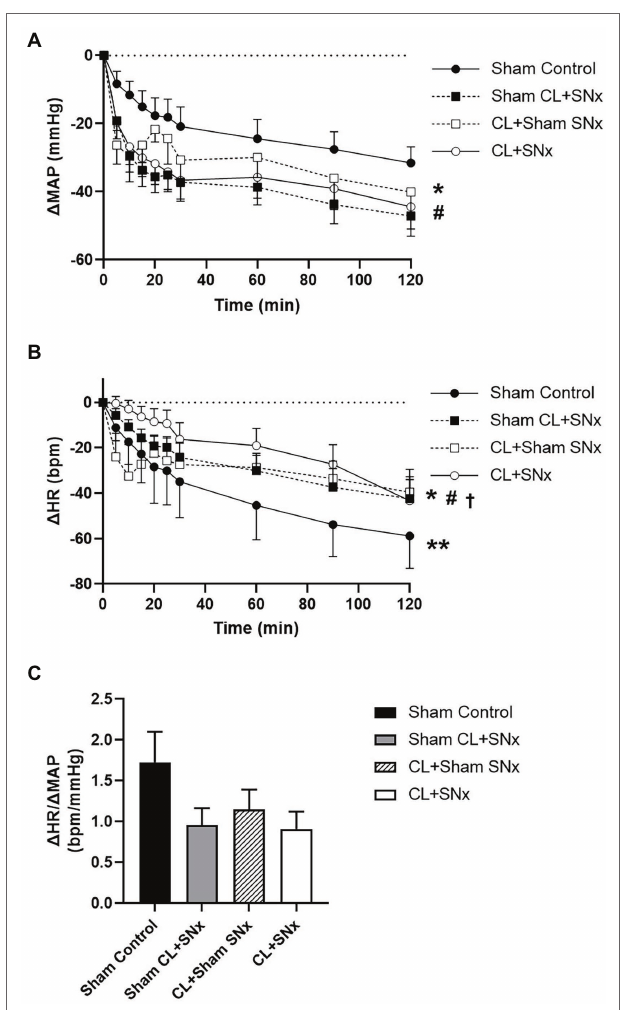
FIGURE 2 | RVP increase induced a significant reduction in MAP and HR in all groups compared to baseline. (A) RVP elevation induced a